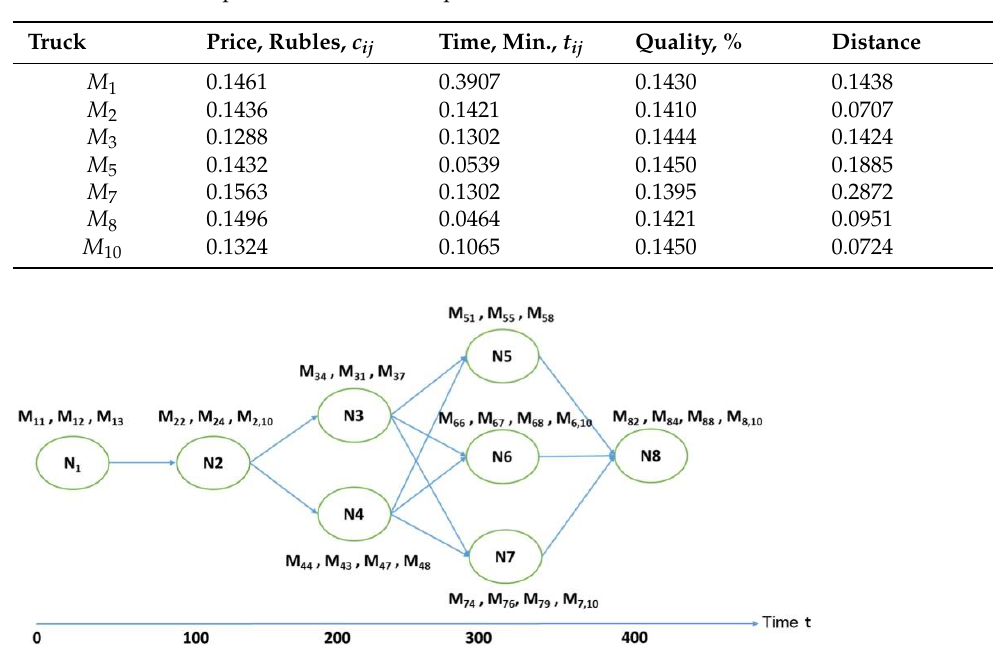
Table 2. Normalized parameters of DP complex of trucks. Truck Price, Rubles, с 𝒊𝒋 Time, Min., 𝒕 𝒊𝒋 Quality, %